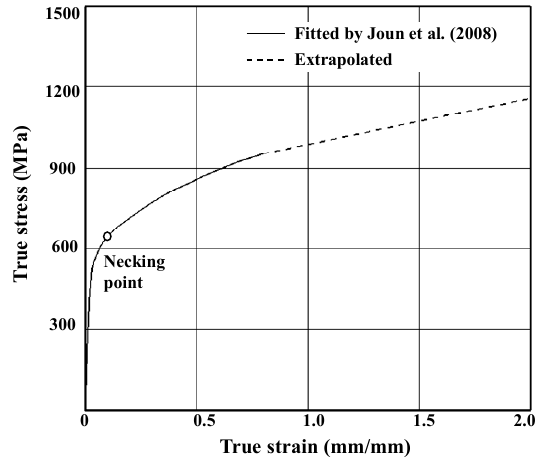
Figure 6. Flow stress determined from the tensile test.